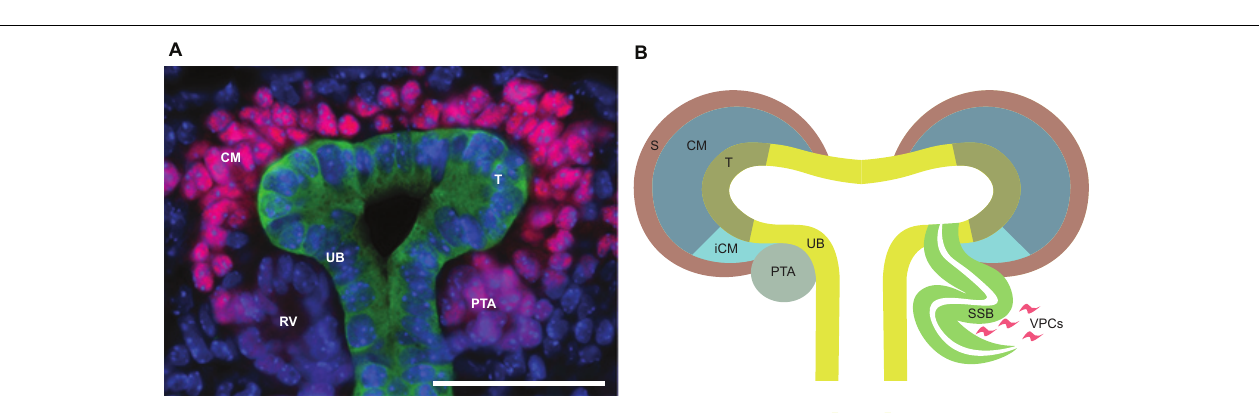
FIGURE 1 | Overview of early kidney development in mouse. At embryonic day 11.0, the ureteric bud (UB) grows out from the nephric duct (ND) and enters the metanephric mesenchyme (MM). By E11.5, the UB bifurcates into two distinct UB tips (T). The cloaca is indicated as (C), and the common nephric duct is indicated as (CND).